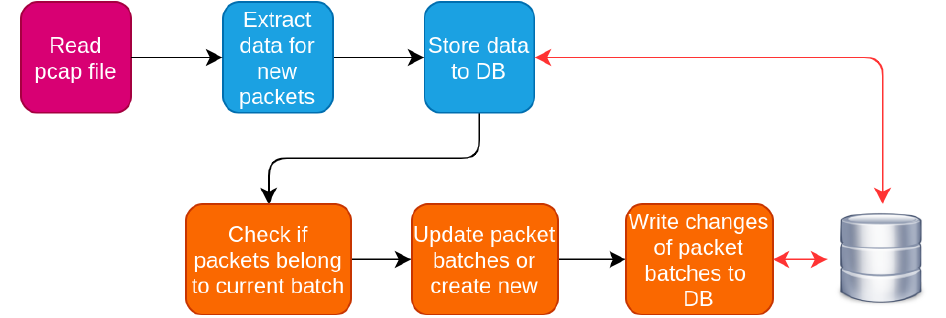
Figure 5. Work-flow for non-IP